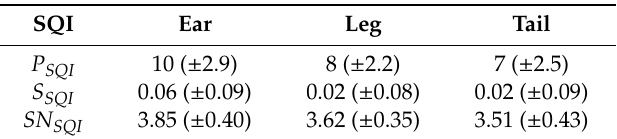
Table 2. The average and standard deviation of the SQIs, perfusion index ( P SQI ), skewness index ( S SQI ) and signal to noise ratio index ( SN SQI ) from all the PPG segments obtained from the ear, leg and the tail of the anaesthetised pig.